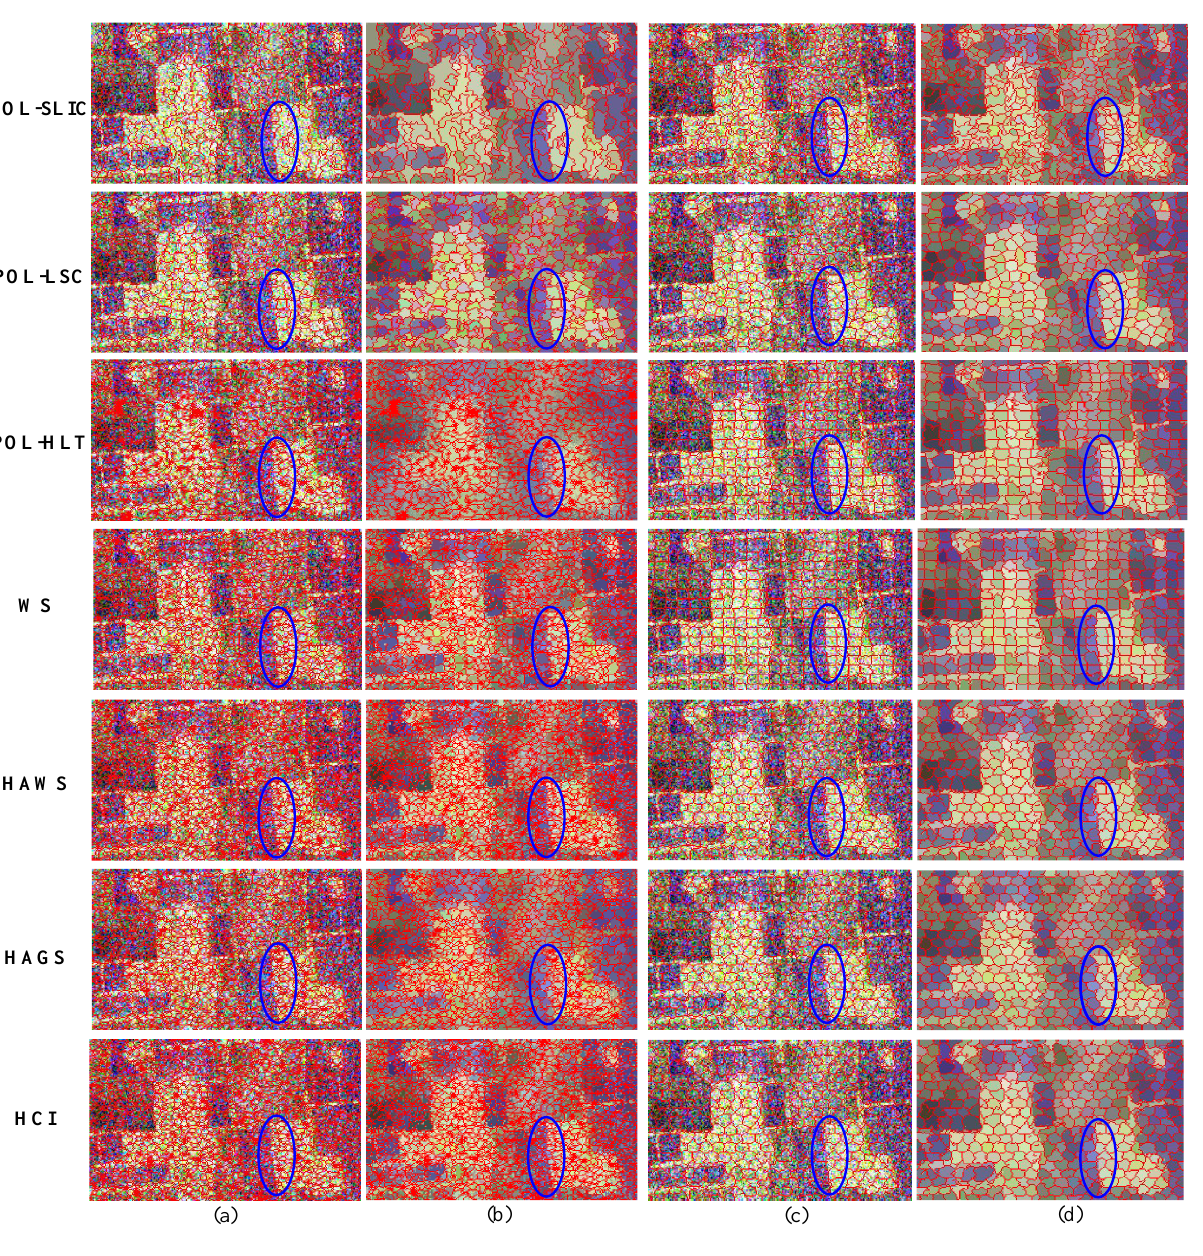
Figure 21. Enlarged regions at the lower right of RADARSAT-2 data set. ( a , b ) are the results based on the unfiltered image, ( c , d ) are the results based on the filtered image using Lee filter with w = 5. The first through seventh rows represent the results of the POL-SLIC, POL-LSC, POL-HLT, WS, HAWS, HAGS, and the proposed